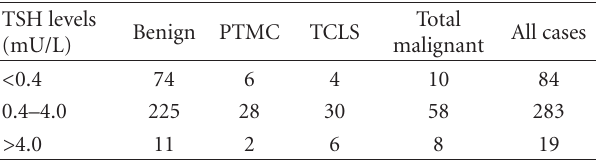
Table 1: Distribution of patients according to TSH categories: < 0.4mU/L (subclinical hyperthyroidism); 0.4–4.0 mU/L